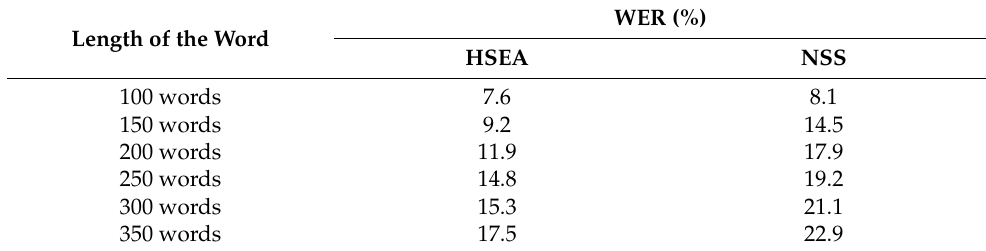
Table 7. WER, accuracy using the HSEA and NSS for RAVDESS.